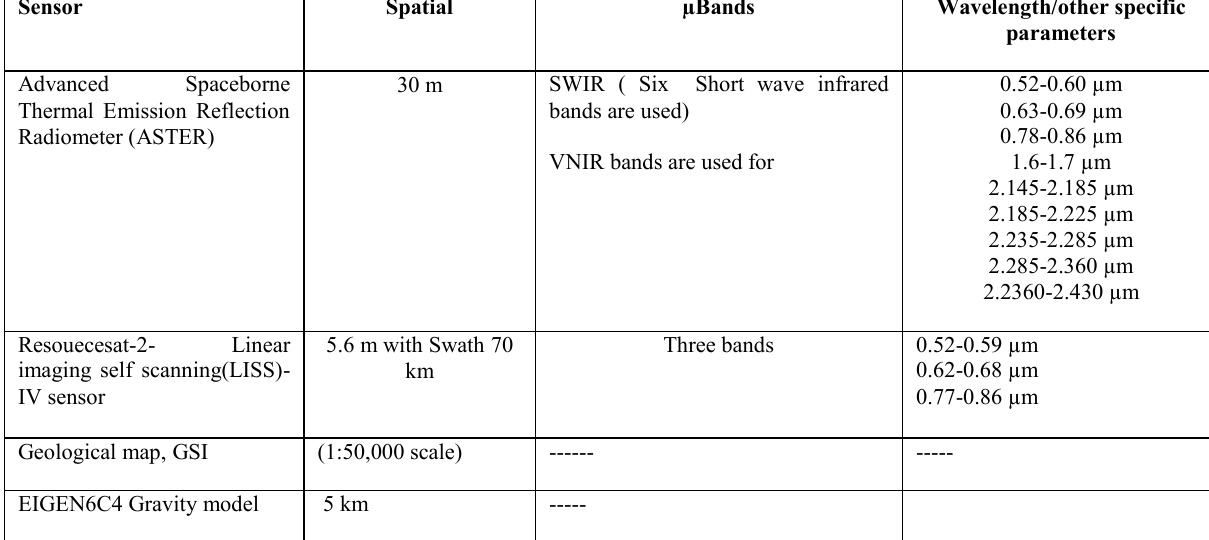
Table 1: Specification of the datasets used for the